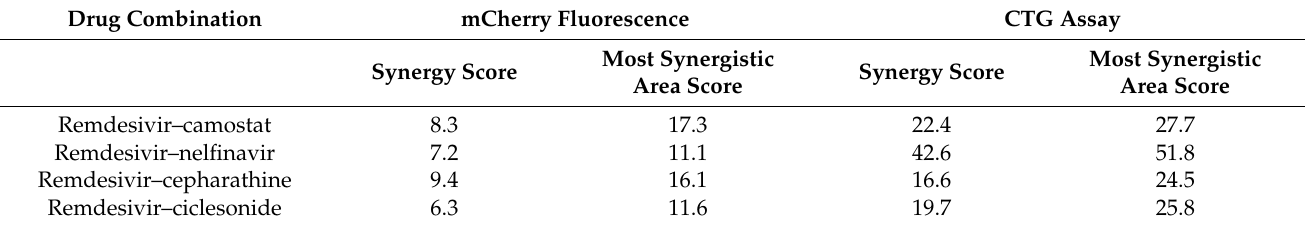
Table 2. ZIP synergy scores of drug combinations in SARS-CoV-2-mCherry-infected Calu-3 cells. Drug